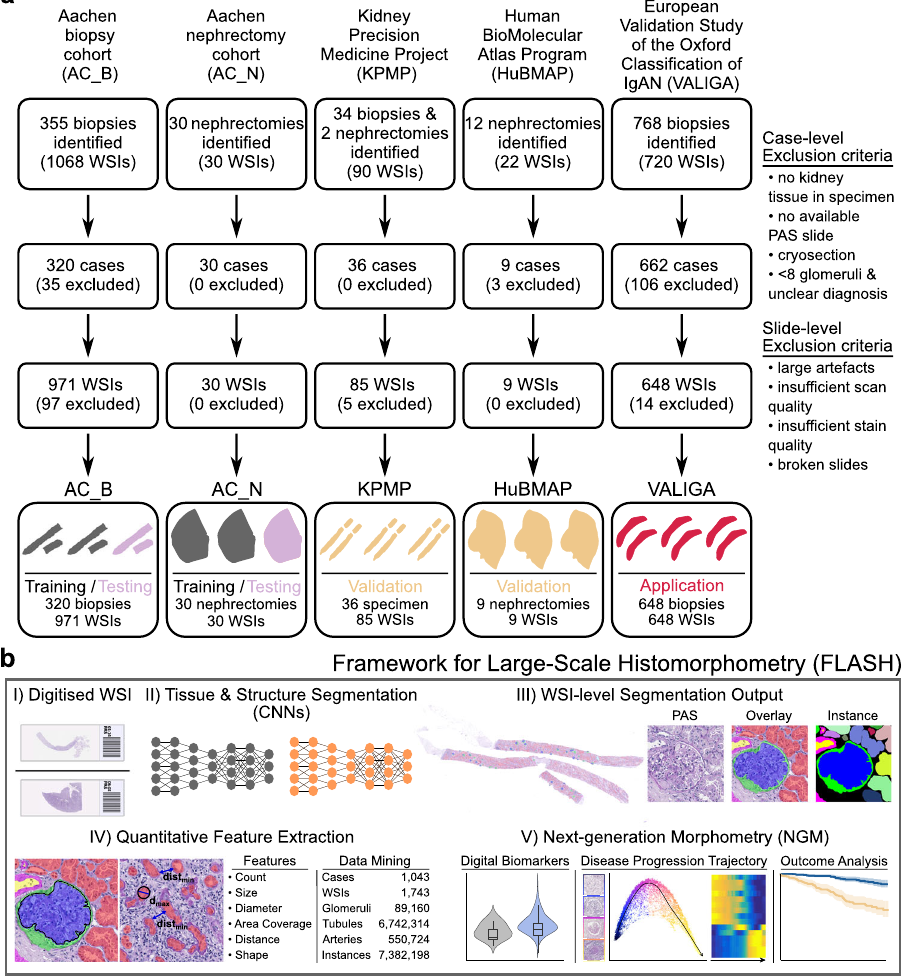
Fig. 1 | Flowchart of the patient cohorts and the integration of our framework for large-scale histomorphometry (FLASH) into a digital pathology work fl ow. a Overview ofthe cohortre fi nement process. Cases and whole-slideimages (WSIs) were excluded based on prede fi ned criteria on case- and slide-level. 1043 cases from fi vecohortsand1743WSIswereincludedinthisstudy. b